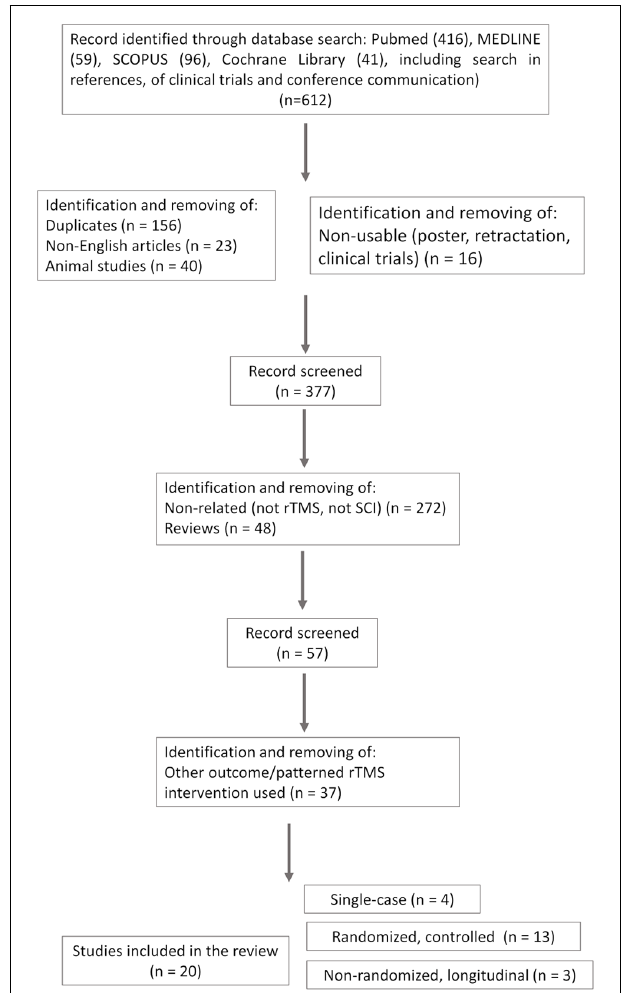
FIGURE 1 | Study selection flow diagram, in accordance with PRISMA-ScR guidelines.